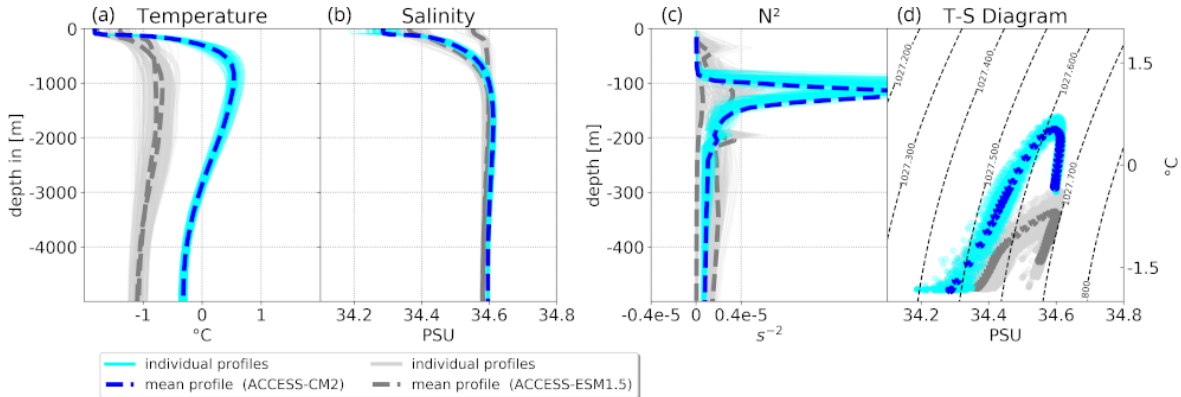
Figure A8. Comparison of the winter profiles of the CMIP6 models ACCESS-ESM1.5 (blue) and ACCESS-CM2 (grey). From left to right: temperature, salinity, Brunt–Väisälä frequency N 2 and T – S